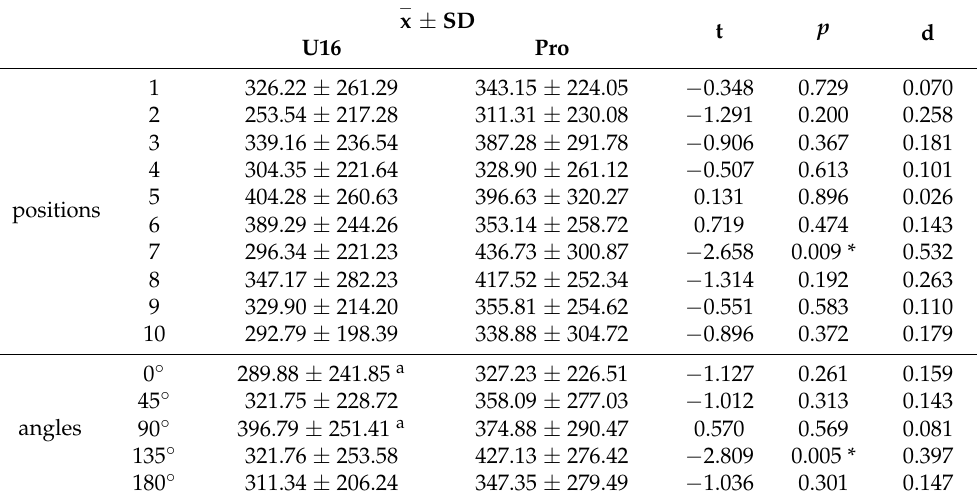
Table 5. Between-group comparison for first fixation duration, according to position and angle (times in